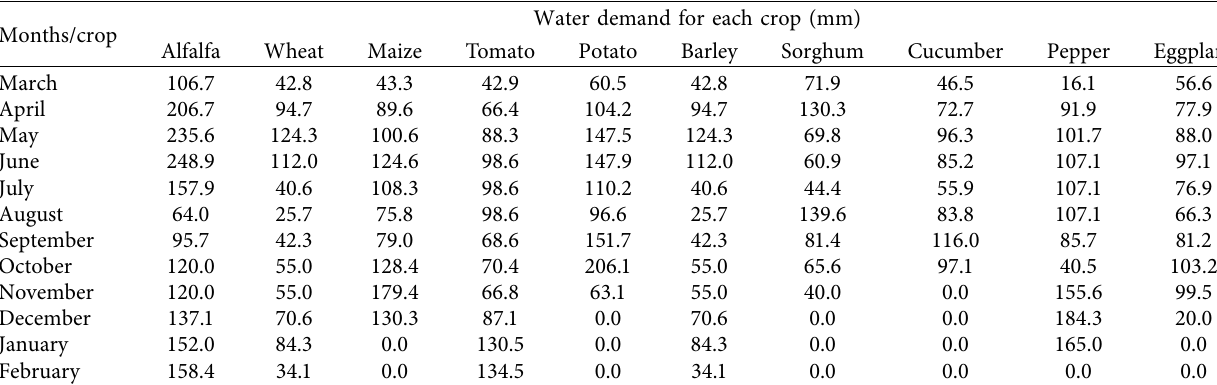
Table 2: Monthly water demand for each crop in mm.